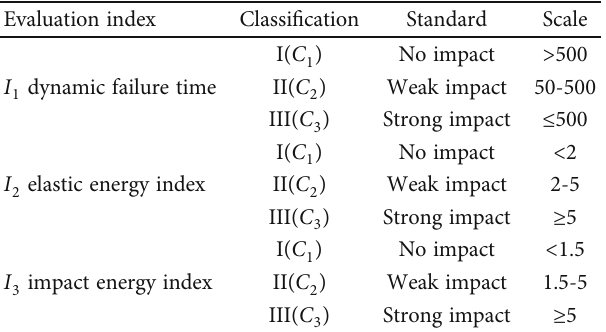
Table 1: Grading standard of the impact evaluation